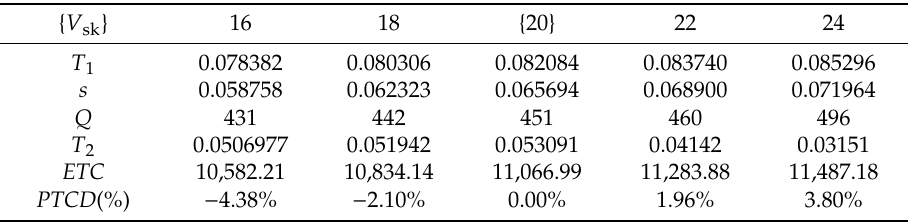
Table 11. Sensitivity analysis when the variable risk cost changes.